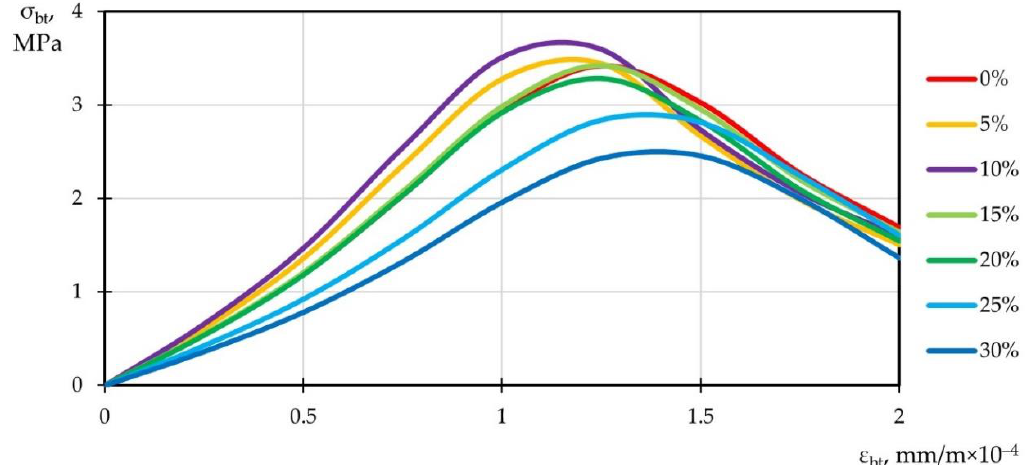
Figure 8. Tensile stress–strain diagram.